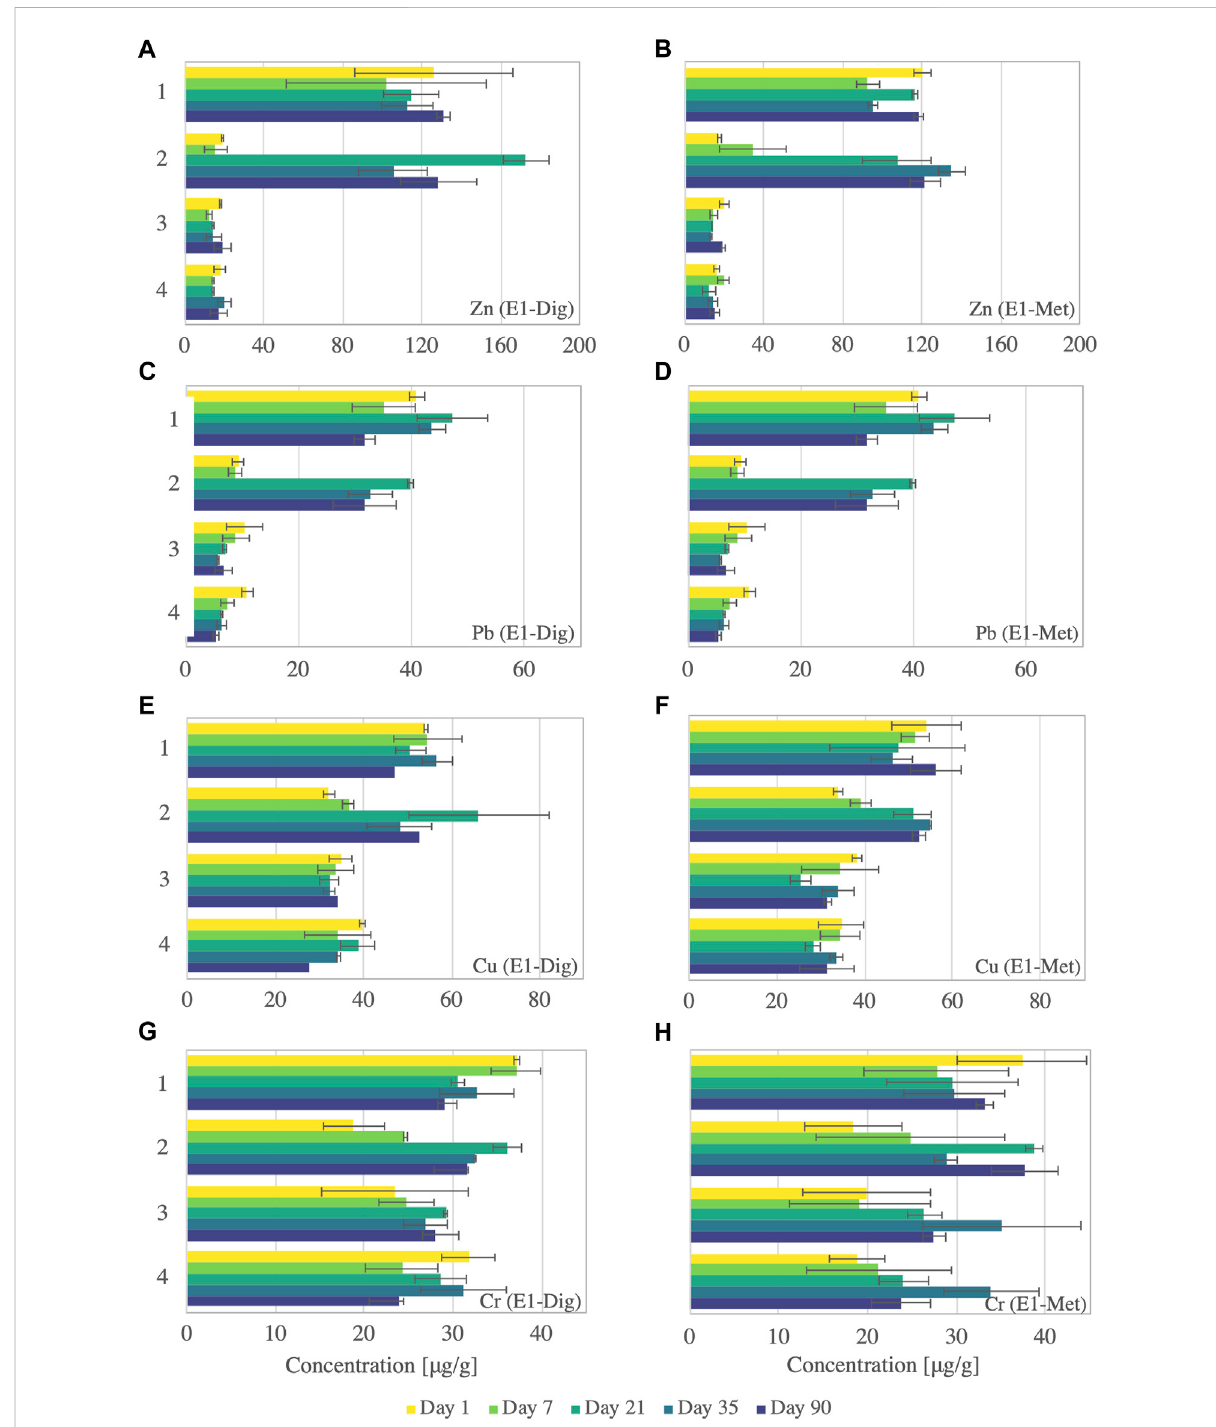
FIGURE 4 Zn, Pb, Cu and Cr total concentrations in the soil of the four column layers (ports 1, 2, 3 and 4) collected throughout time, for the two experimental conditions: E1-Dig [soil amended with digestate (A,C,E,G) ] and E1-Dig-Met [soil amended with digestate doped with metformin (B,D,F,H) ] (mean ± standard deviation, n =